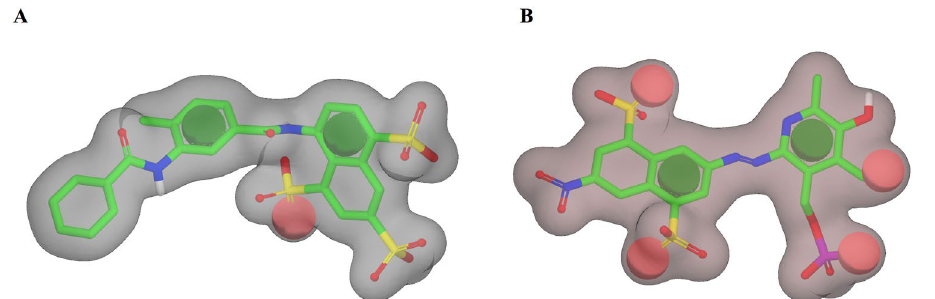
Figure 3. Queries generated using vROCS. ( A ) Query generated using the partial structure of suramin. ( B ) Query generated using the structure of PPNDS. The overall molecular shape of both the inhibitors is represented as a grey surface, while the chemical features considered are an H-bond acceptor (red sphere) and hydrophobic/aromatic centres (green